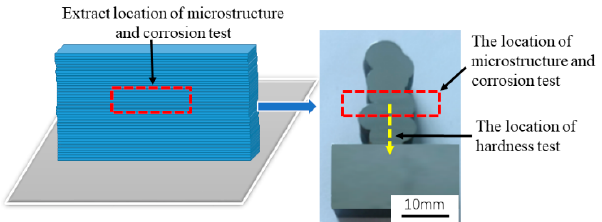
Figure 2. The extract location of microstructure, hardness test, and corrosion test.